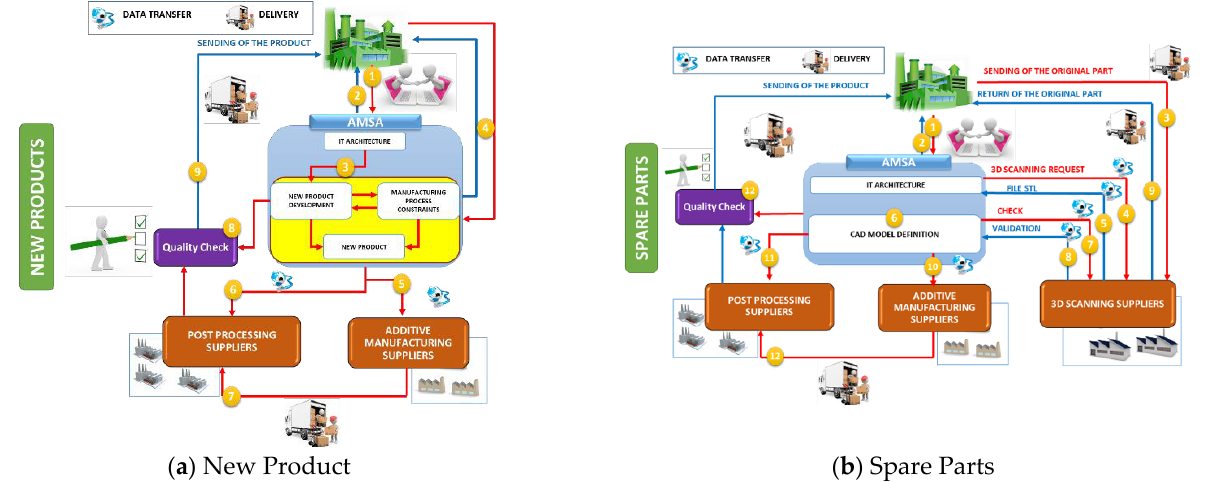
Figure 1. AMSA (Additive Manufacturing Spare parts market Application) supply chain: ( a ) new product; ( b ) spare part. Table 1. Matrix example that associates the Key Performance Indicator (KPIs) with the various machine types available on the platform (Powder Bed, PB or Directed Energy Deposition,